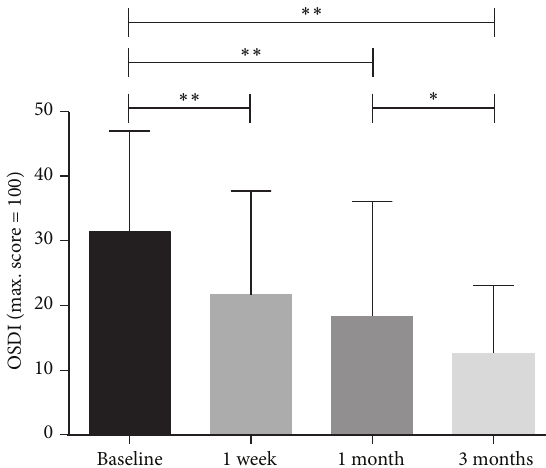
Figure 2: The mean value of test-eye Ocular Surface Disease Index (OSDI) at baseline, at one week, at one month, and at three months ( ∗ 𝑝 < 0.05 , ∗∗ 𝑝 < 0.001